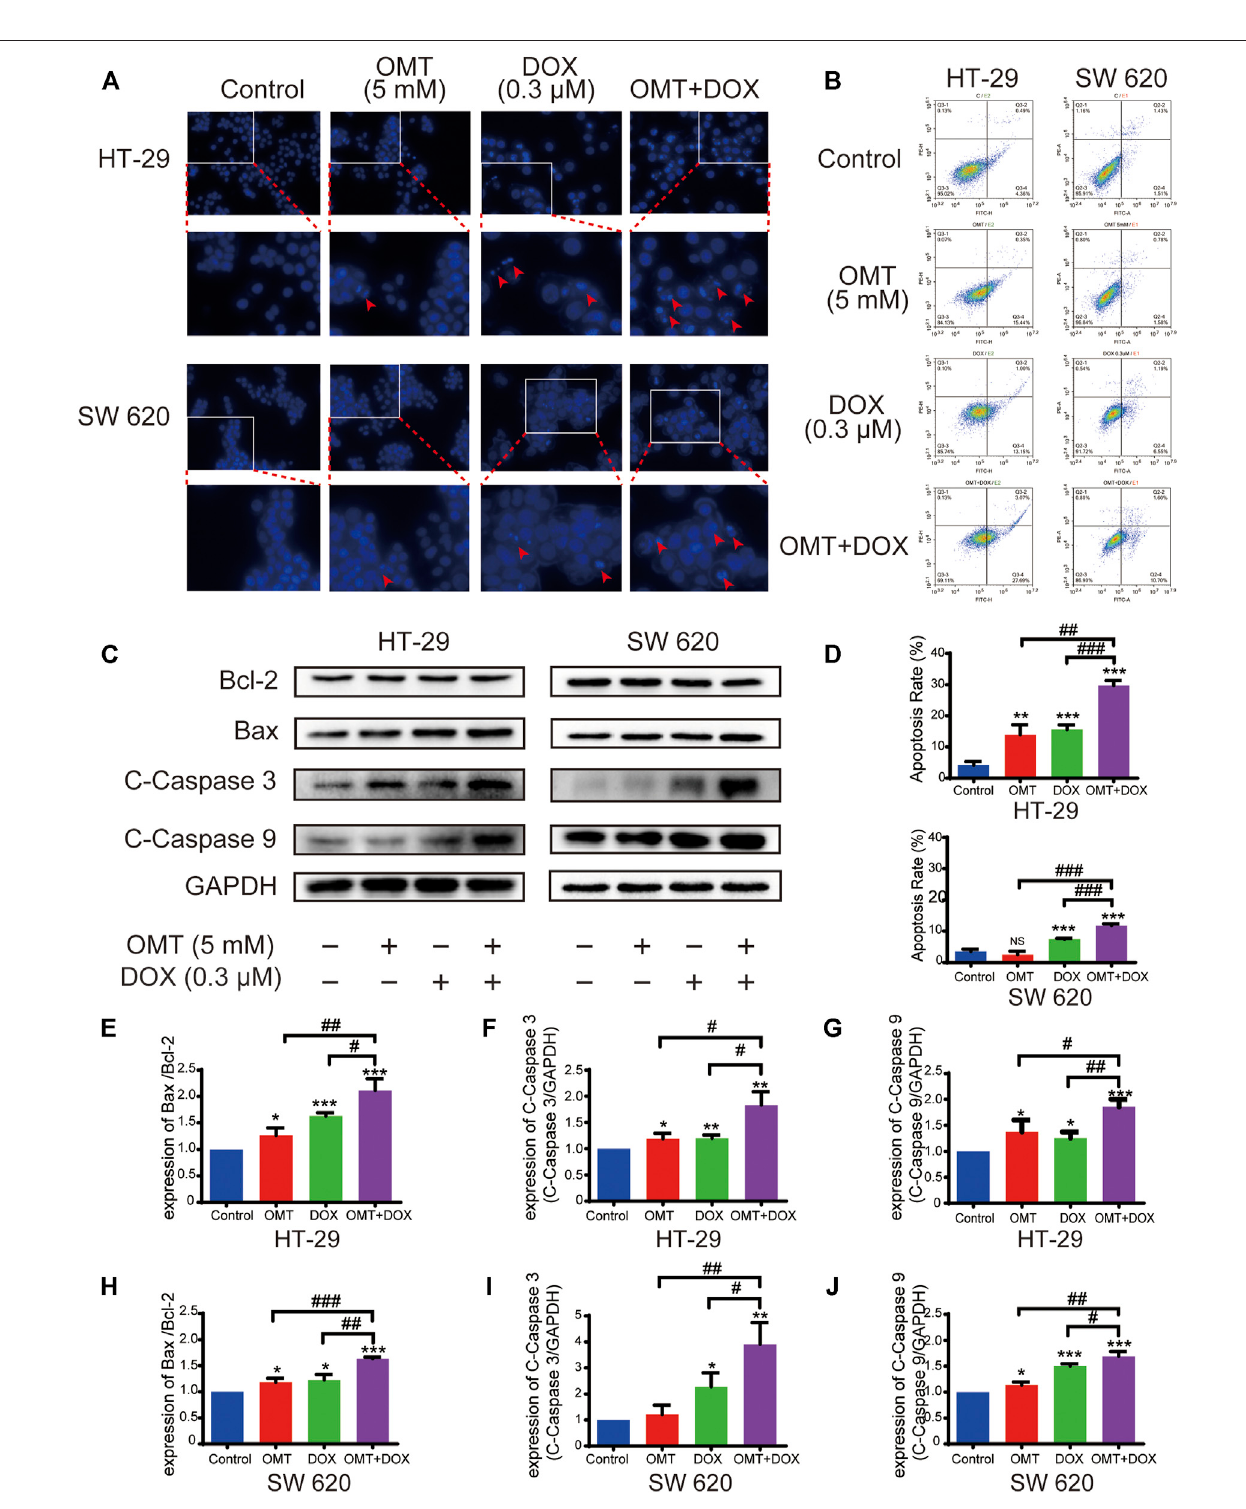
FIGURE 3 | OMT combined with DOX induced apoptosis of CRC cells. (A) DAPI staining (blue) was used to observe the changes in the nucleus of HT-29 and SW620 cellsunderOMTorDOXtreatment. (B) Cellapoptosiswasdetected byAnnexin V-FITC/PIbindingassayafter OMTand/orDOXtreatment inHT-29andSW620 cells. (C) Western blotting was used to analyze the expression of Bcl-2, Bax, cleaved caspase-3, and cleaved caspase-9. (D) Statistical analysis oftotal apoptosis rates includingearlyandlateapoptosis(Q2+Q4,respectively). (E – J) Thedensitometricanalysisofproteinbandswasperformedandnormalizedwiththecorresponding GAPDHcontent.Dataarepresentedasthemean ± SDofthreeindependentexperiments.* p < 0.05,** p < 0.01,*** p < 0.001vs.thecontrolgroup; # p < 0.05, ## p < 0.01, ### p < 0.001 vs. the OMT (5 mM) group or DOX (0.3 μ M) group.